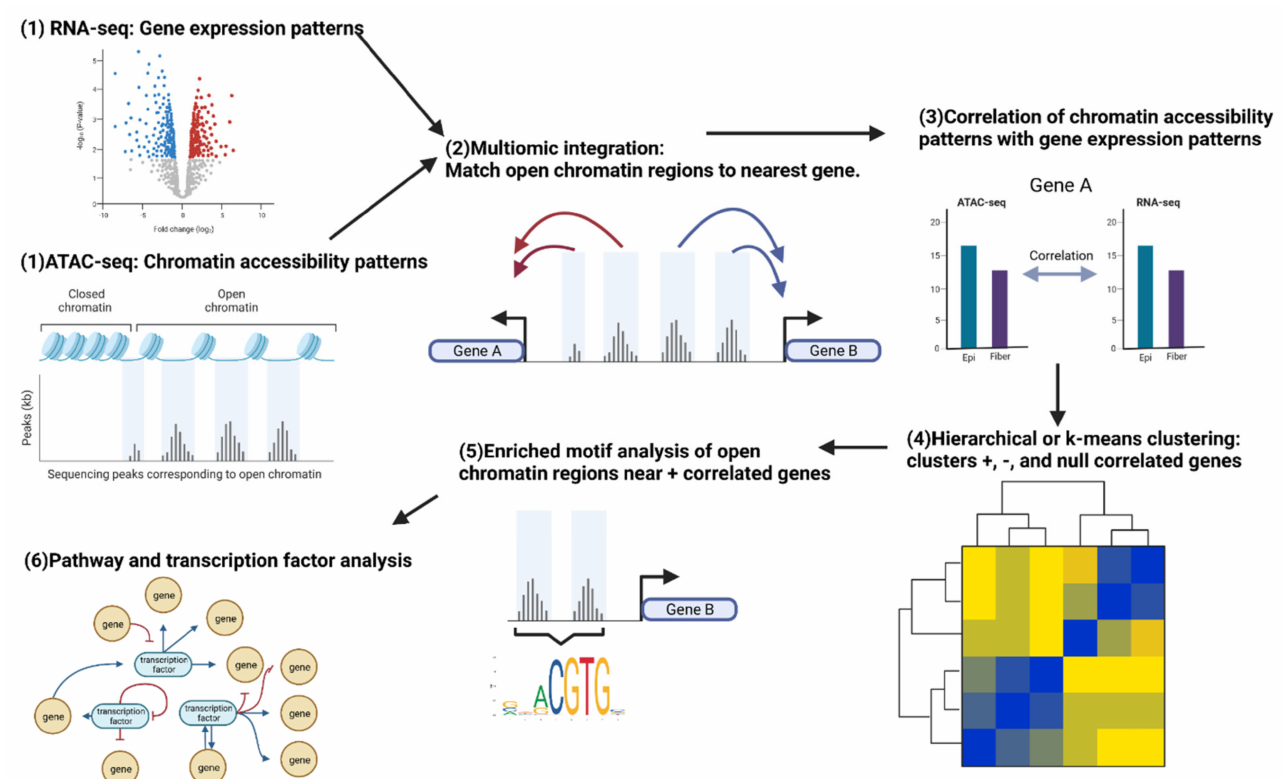
Figure 4. Workflow for a multiomics experiment integrating RNA-seq and ATAC-seq data comparing lens epithelial cells and fiber cells. The figure shows the integration of RNA-seq and ATAC-seq data using bioinformatics tools and statistical analysis methods, enabling the identification of potential regulatory regions, transcription factors, and gene expression patterns that contribute to lens dif- ferentiation. The integrated analysis allows for a comprehensive understanding of the molecular mechanisms underlying lens cell differentiation. Created with BioRender.com